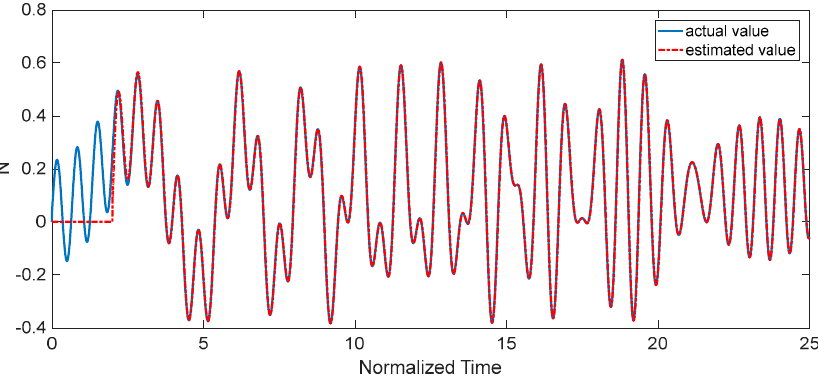
Figure 5. Results of the proposed estimator.